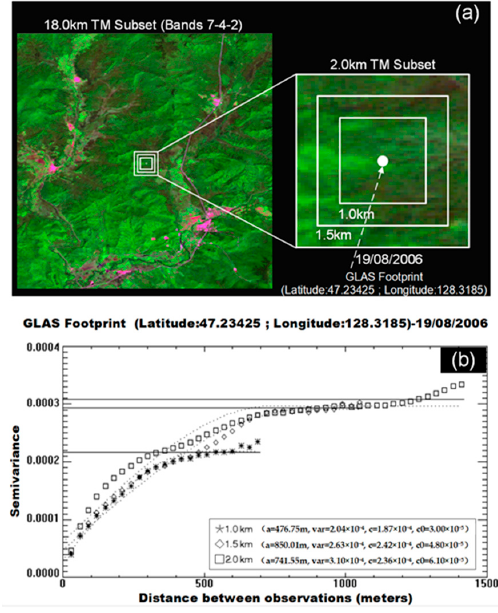
Figure 4. ( a ) Shortwave bidirectional reflectance factor (BRF) composites (Landsat-TM 7-4-2 band) centered on a GLAS footprint (lat: 47.23425; lon: 128.3185) in Heilongjiang, China, at ground level. Trees are indicated by the shades of green, bare areas are shown in pale-pink, and water is black. ( b ) Variogram estimators (points), spherical model (dotted curves), and sample variance (solid straight lines) obtained over this GLAS footprint using surface reflectance derived from the TM scene on 19 August 2006 with spatial thresholds of 1 km, 1.5 km and 2.0 km as a function of distance from the center of the GLAS observation.